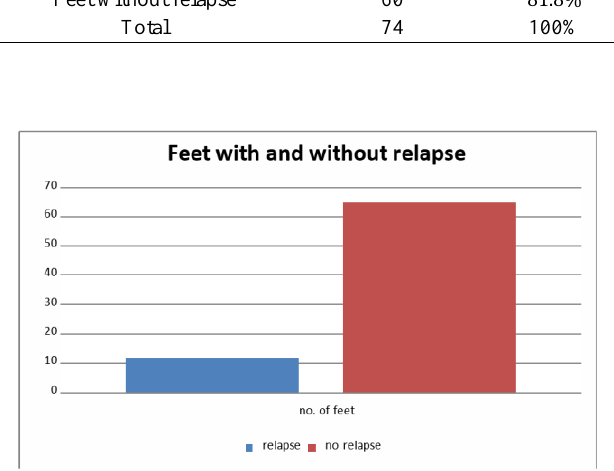
Figure 3 : Bar chart showing number of feet with and without relapse